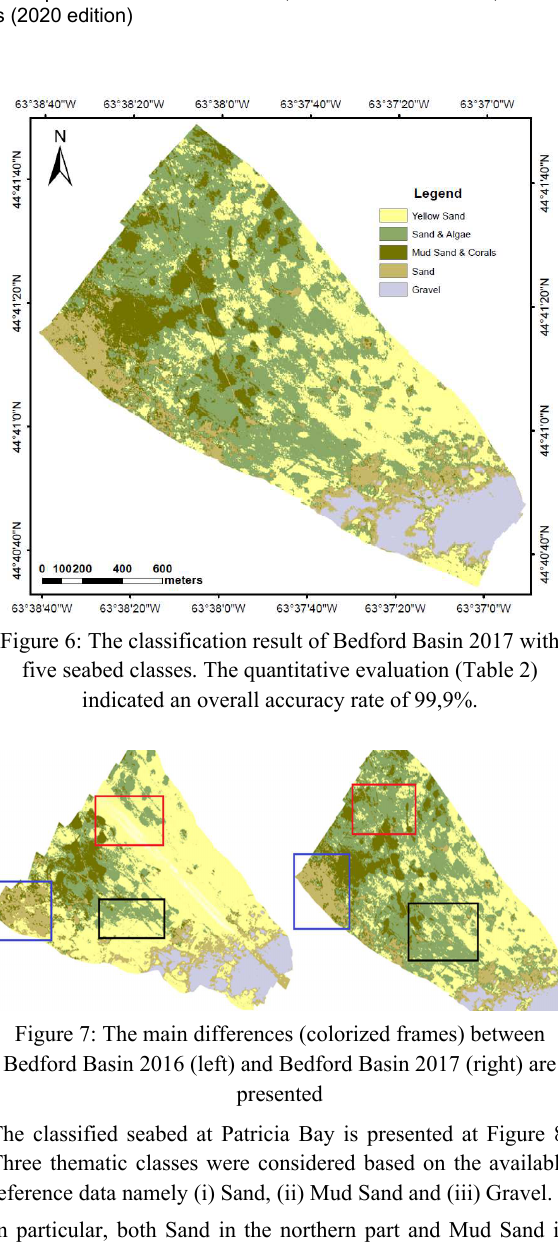
Figure 7: The main differences (colorized frames) between Bedford Basin 2016 (left) and Bedford Basin 2017 (right) are presented The classified seabed at Patricia Bay is presented at Figure 8. Three thematic classes were considered based on the available reference data namely (i) Sand, (ii) Mud Sand and (iii) Gravel. In particular, both Sand in the northern part and Mud Sand in the southern, are covering a quire large proportion of the region. Gravel was mainly detected on the boundaries of the southern and northern part of the region. As for the quantitative evaluation indicated a relatively high OA of 98,8% (Table 3).